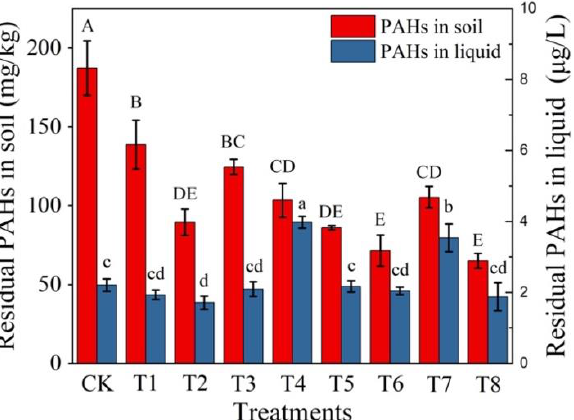
Figure 4. PAHs in soil and liquid phase after incubation for 24 days. Different letters (A – E and a – d) indicate significant differences in the concentrations of PAHs among different treatments according to the one-way analysis of variance (ANOVA) test followed by Tukey’s post hoc tests.